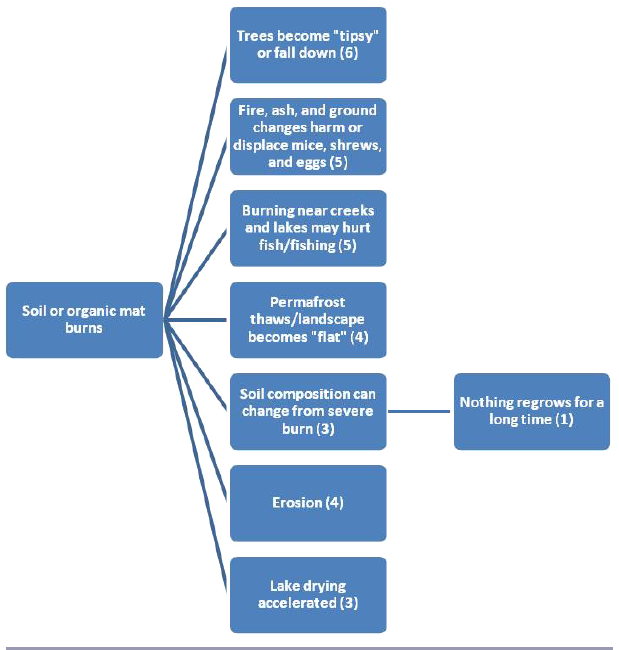
Fig. 8 . Fire effects as reported by Koyukon respondents. First column represents type of burn, second column represents primary effects, and third column represents secondary effects. Note that the numbers in parentheses refer to the number of respondents who provided that